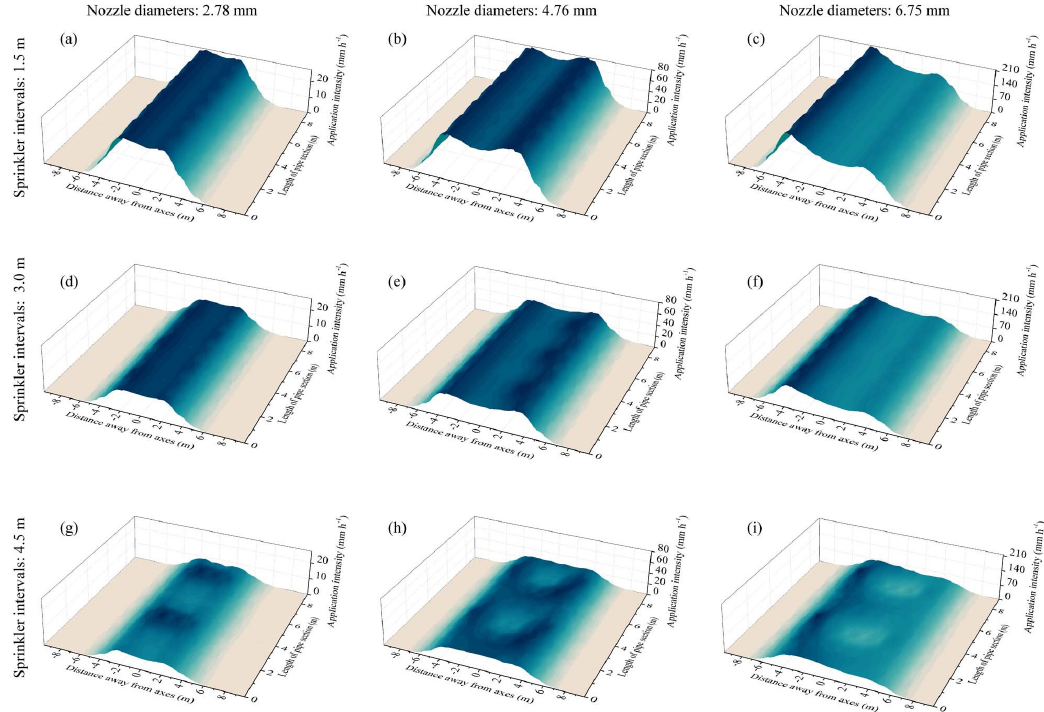
Figure 8. Water distribution characteristics of same-nozzle-sprinkler pipe sections with fixed spray plate sprinklers (FSPSs). The figures in different columns and rows indicate different nozzle diameters (2.78, 4.76, and 6.75 mm) and sprinkler intervals (1.5, 3.0, and 4.5 m): FSPS—2.78—1.5 ( a ), FSPS—4.76—1.5 ( b ), FSPS—6.75—1.5 ( c ), FSPS—2.78—3.0 ( d ), FSPS—4.76—3.0 ( e ), FSPS—6.75—3.0 ( f ), FSPS—2.78—4.5 ( g ), FSPS—4.76—4.5 ( h ) and FSPS—6.75—4.5 ( i ).